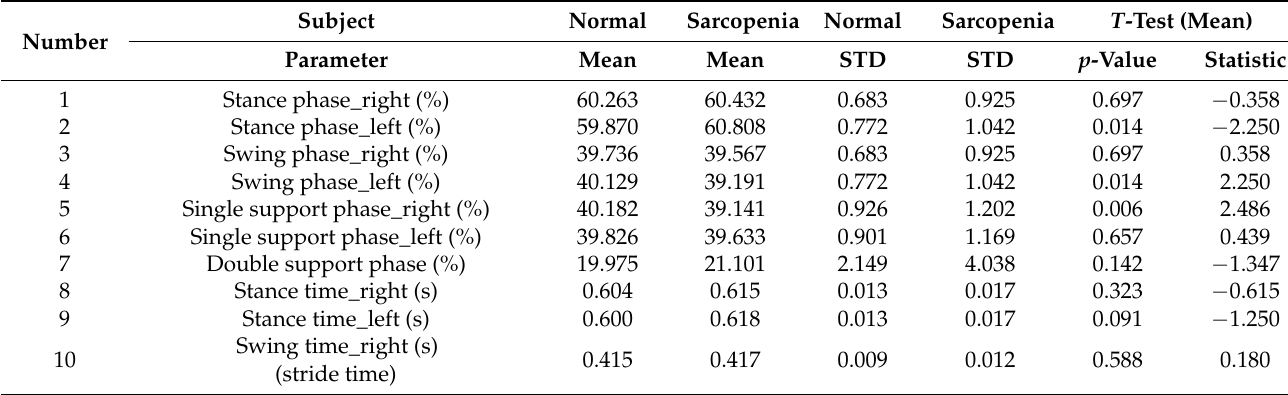
Table A1. Spatial-temporal